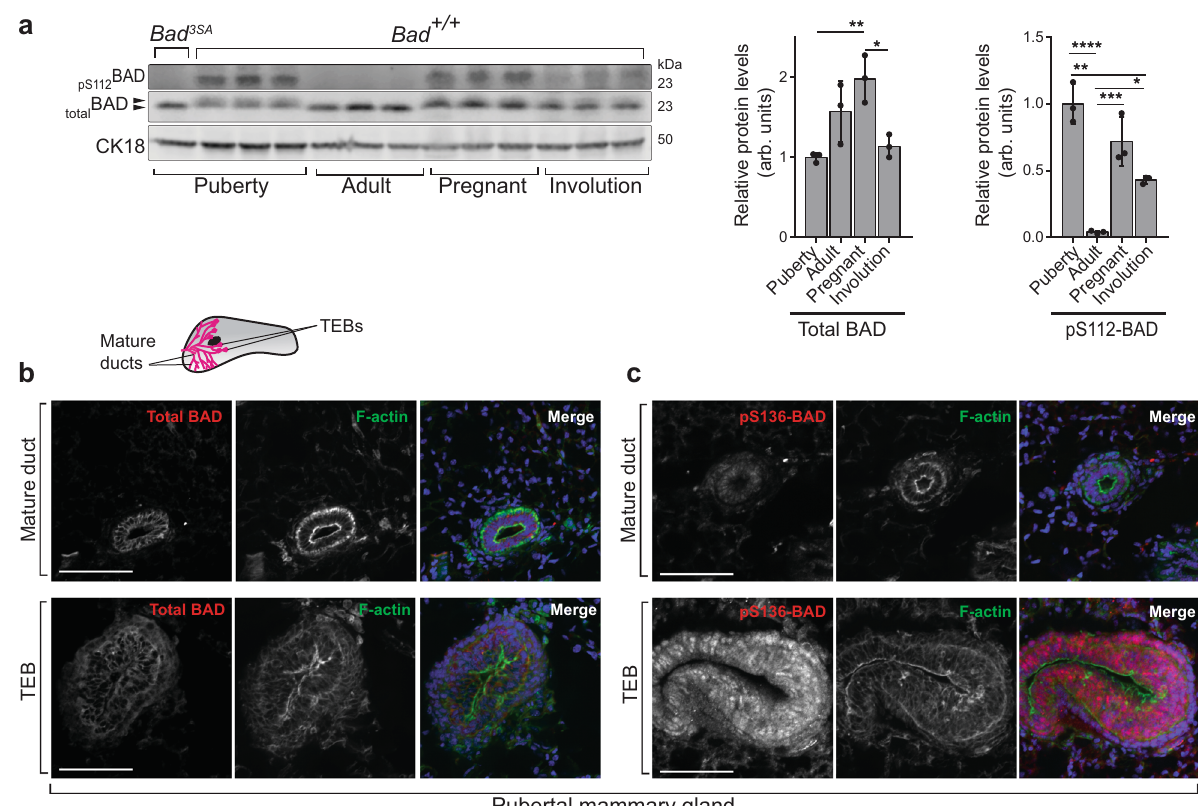
Fig. 1 BAD is differentially phosphorylated in the developing mammary gland. a Left: western blots of P-BAD and total BAD from Bad + / + mammary glands at indicated stages (Puberty at 5wk; Adult at 12wk; Pregnant; Involution). Each lane contains lysates from independent mice. Control Bad 3SA mammary gland lysate ( fi rst lane) shows speci fi city of anti-pS112-BAD antibody. Black arrowheads highlight gel shift indicative of BAD phosphorylation. CK18 is used as the loading control for the epithelial compartment. Middle: quantitation of total BAD relative to CK18 loading control, shows increased BAD levels in pregnancy with similar levels in other stages. Right: quantitation of pS112-BAD relative to total BAD shows decreased phosphorylation in adult glands with highest levels in pubertal stages. Data are mean ± SD. For each stage, three independent mice were used. b , c Representative immuno fl uorescent images from n = 3 independent mice of Bad + / + pubertal mammary glands stained for b total BAD and c P-BAD with pS136BAD antibody. The pubertal epithelial tree is composed of bilayer mature ducts capped by multilayer TEBs (inset schematic). Regions representing mature ducts (upper) and TEBs (lower) within the same tissue sections are shown. Total BAD (red), pS136-BAD (red), F-actin (green) and DAPI (blue). BAD localized to the epithelial cells in all experiments. bars = 100 µ m. For all p -values, *** P < 0.001, ** P < 0.01, * P < 0.05. Statistical test details and exact p -values are provided in Supplementary Data 4. Source data are provided in the Source data fi